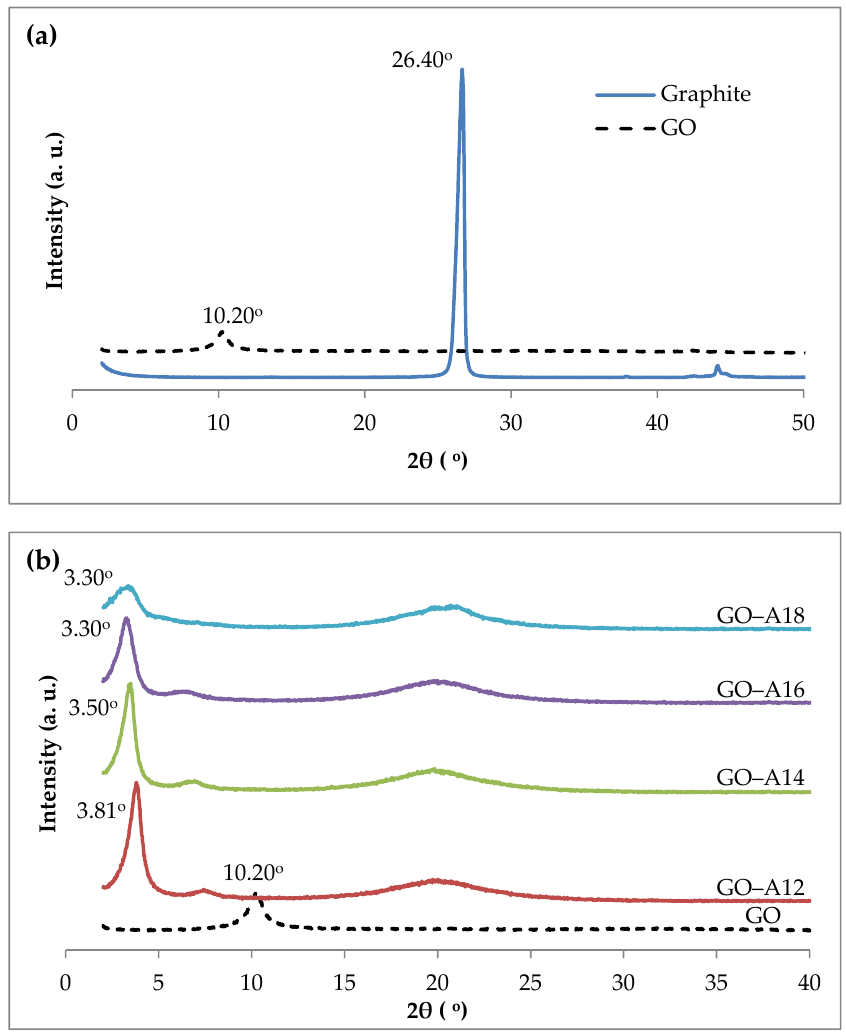
Figure 1. XRD spectra of ( a ) graphite and GO; and ( b ) functionalized GO.